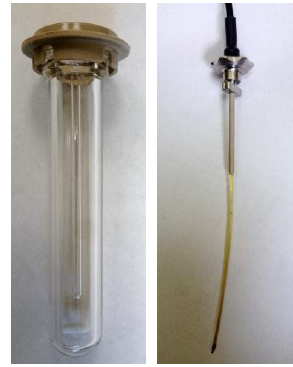
Figure 4. Photographs of a typical 10 mL microwave reaction vessel with a stir-bar and fiber-optic thermometer insert ( left ) and the fiber-optic thermometer ( right ). The glass insert provides values of the internal temperature, but is limited by response time and heat transfer through the insert.